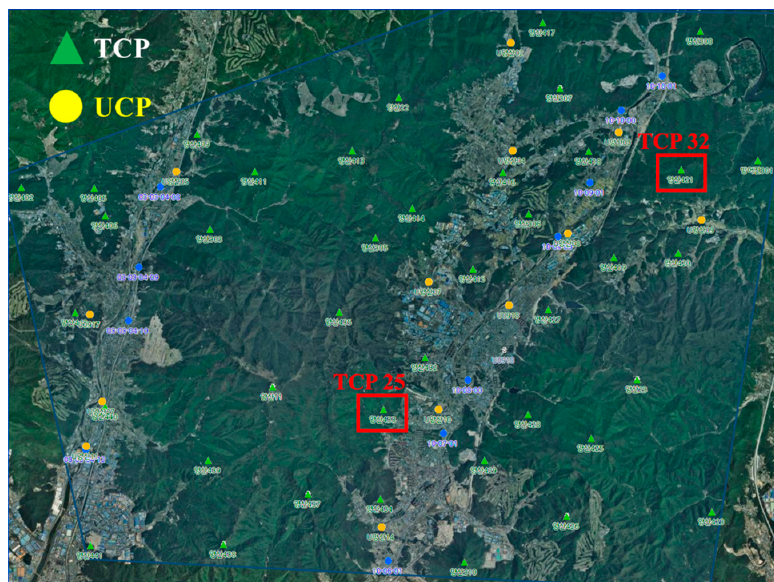
Figure 5. Distribution of unified control points (UCPs) (yellow dots) and triangulation control points (TCPs) (green triangles) in the Yangsan project region as shown on the NGII website. The two highlighted TCPs (#25 and #32) are discussed in more detail in the analysis of the results.